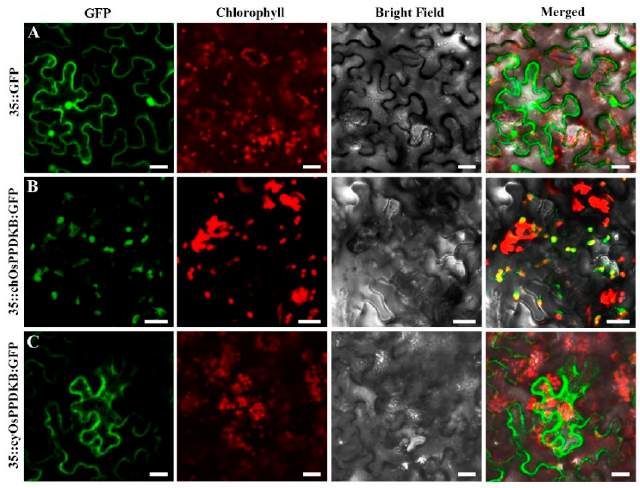
Figure 6. Subcellular localization of OsPPDKB-GFP fusion proteins in Nicotiana benthamiana leaf. ( A ) The free GFP serves as a control. ( B ) The chOsPPDKB-GFP fusion protein is localized in the chloroplasts. ( C ) The cyOsPPDKB-GFP fusion protein is localized in the cytoplasm. Bars = 20 μ m.